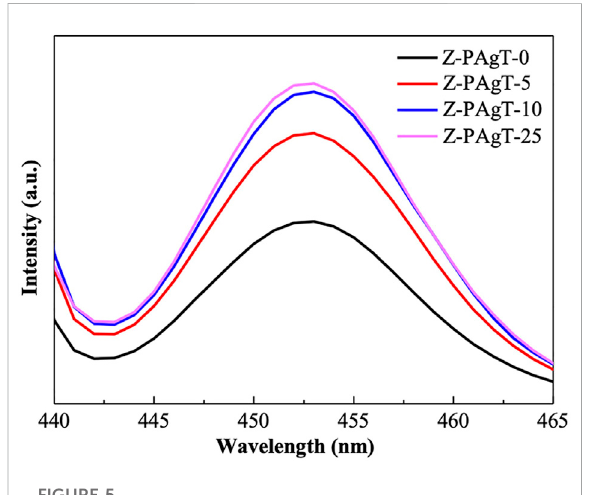
FIGURE 5 PL spectra of the prepared Z-PAgT composite materials with different wt% zeolite addition and pure zeolite.